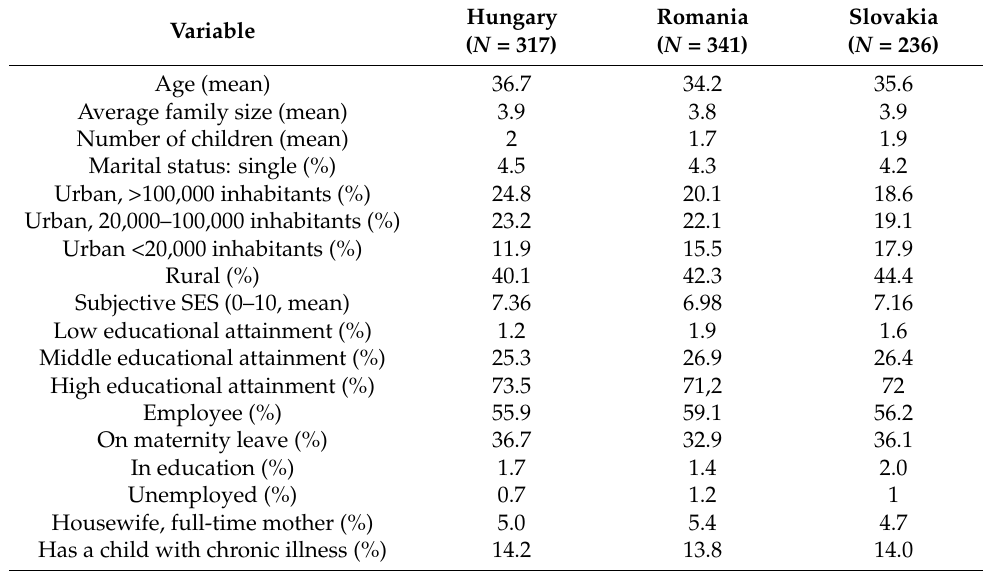
Table 1. Sample characteristics across the three countries, N = 894. Variable